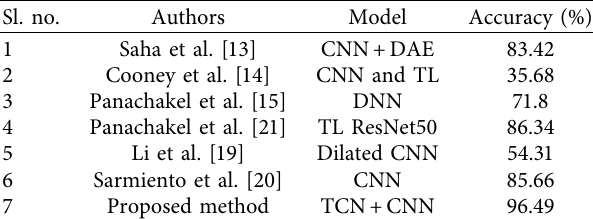
Figure 6: The histogram depicts the proposed model evaluation accuracy for the imagined speech classification of EEG signals across all subjects. Table 4: Comparison of the proposed model with the state of the art. Sl.